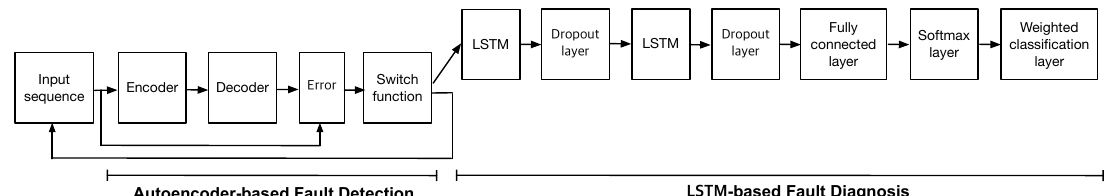
Figure 1. Structure of combined autoencoder and long short-term memory (LSTM) network for fault detection and fault